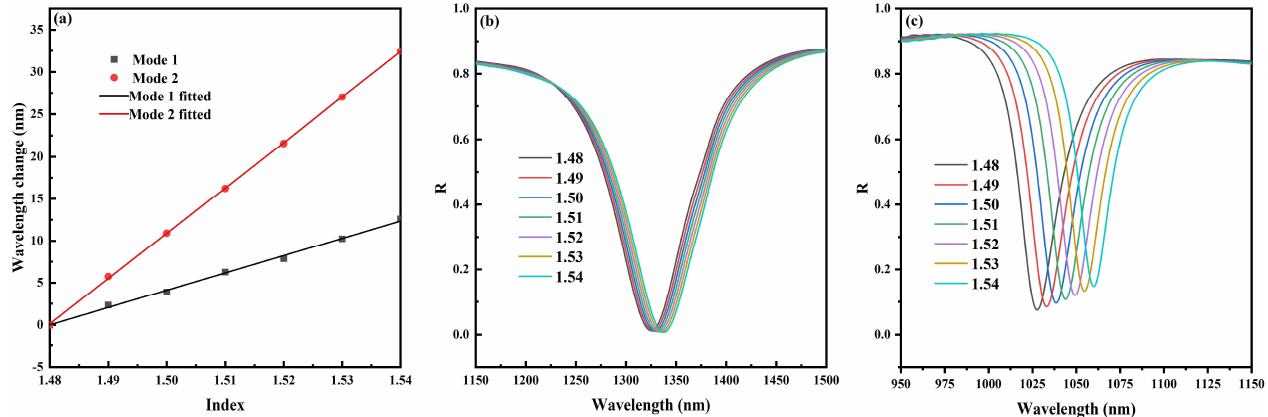
Figure 4. ( a ) The absorption peak wavelength of mode 1 ( b ) and mode 2 ( c ) with surrounding RI changing from 1.48 to 1.54.